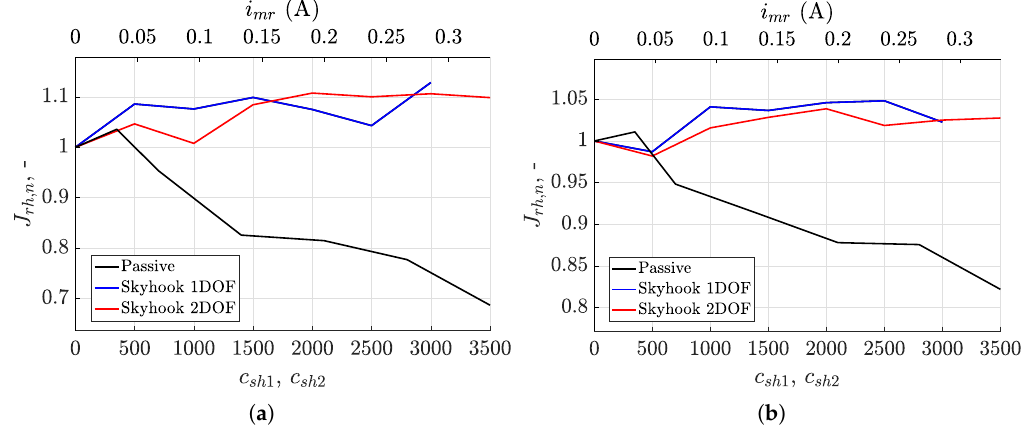
Figure 18. Comparison of road holding for different suspension settings: passive, separate and coupled Skyhook control for vehicle longitudinal velocity of 5 ms − 1 : ( a ) front wheel during braking, ( b ) rear wheel during